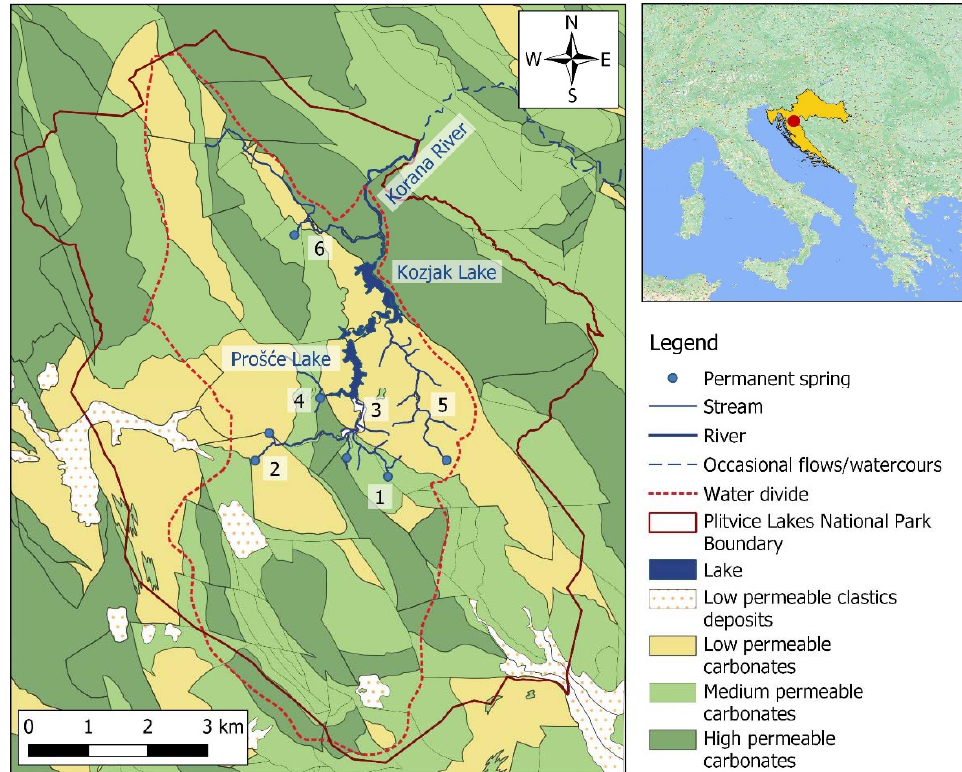
Figure 1. Schematic hydrogeological map of the Plitvice Lakes National Park catchment area (1—Crna Rijeka; 2—Bijela Rijeka; 3—Matica; 4—Sušanj; 5—Rje č ica; 6—Plitvica). (Modified from [22]).